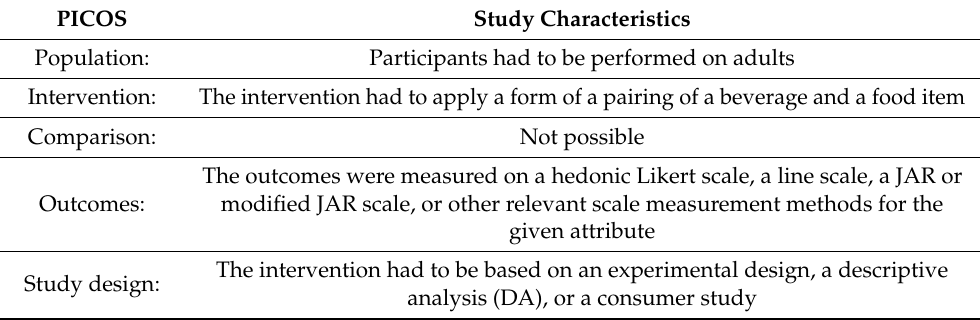
Table 1. Inclusion criteria used for eligibility. PICOS Study